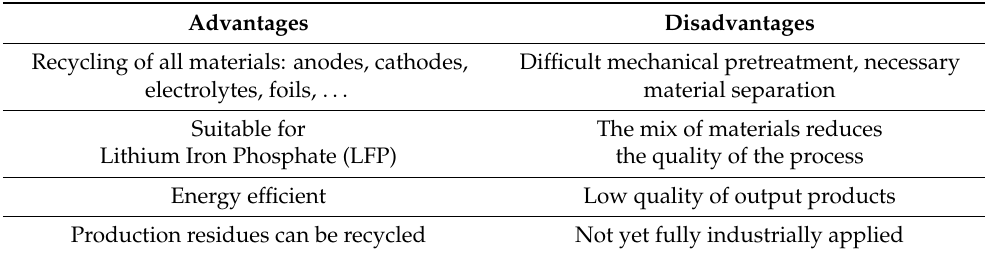
Table 8. Advantages and disadvantages of the process of direct recycling according to [51]. Advantages Disadvantages Recycling of all materials: anodes, cathodes, Difficult mechanical pretreatment, necessary electrolytes, foils, . . . material separation Suitable for Energy